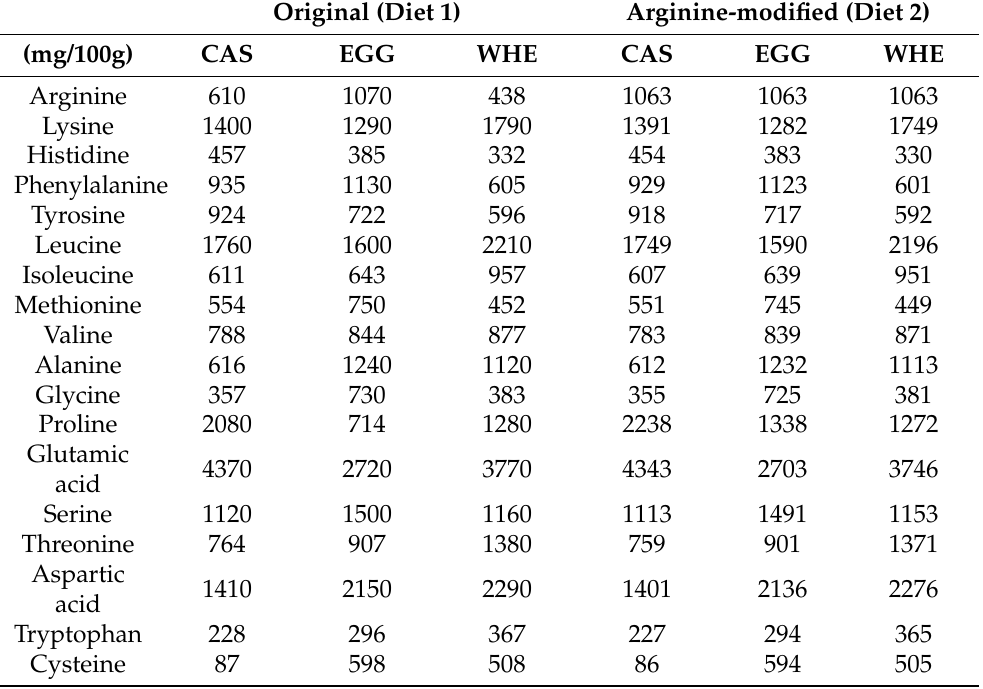
Table 2. Composition of amino